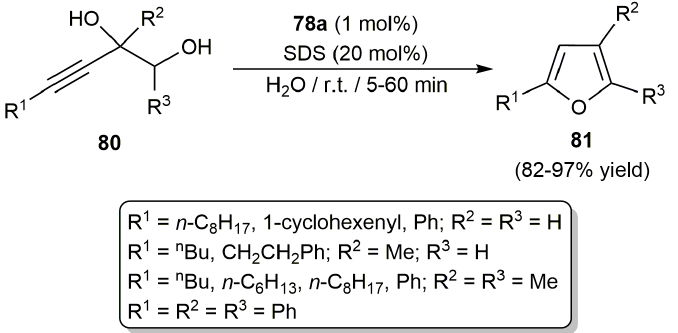
Figure 3. Structure of the amphiphilic N -heterocyclic carbene-gold(I) complexes 78a-b and 79 . Complex 78a was successfully applied as a recyclable catalyst in the dehydrative cyclization of several alkynediols 80 to furans 81 in water, showing the best performances when the co-surfactant sodium dodecyl sulfate (SDS) was added to the reaction medium (Scheme 19) [89]. Although in less detail, the usefulness of 78a-b and 79 to promote the cyclization of γ -alkynoic acids and allenic alcohols was also